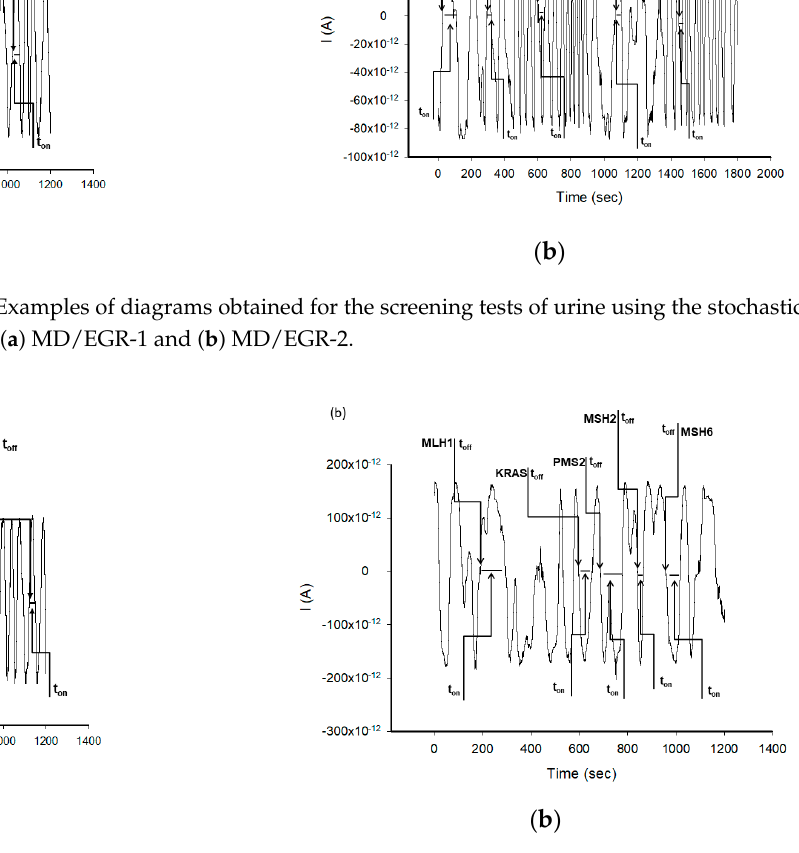
Figure 3. Examples of diagrams obtained for the screening tests of saliva using the stochastic sensors based on: ( a ) MD/EGR-1 and ( b )